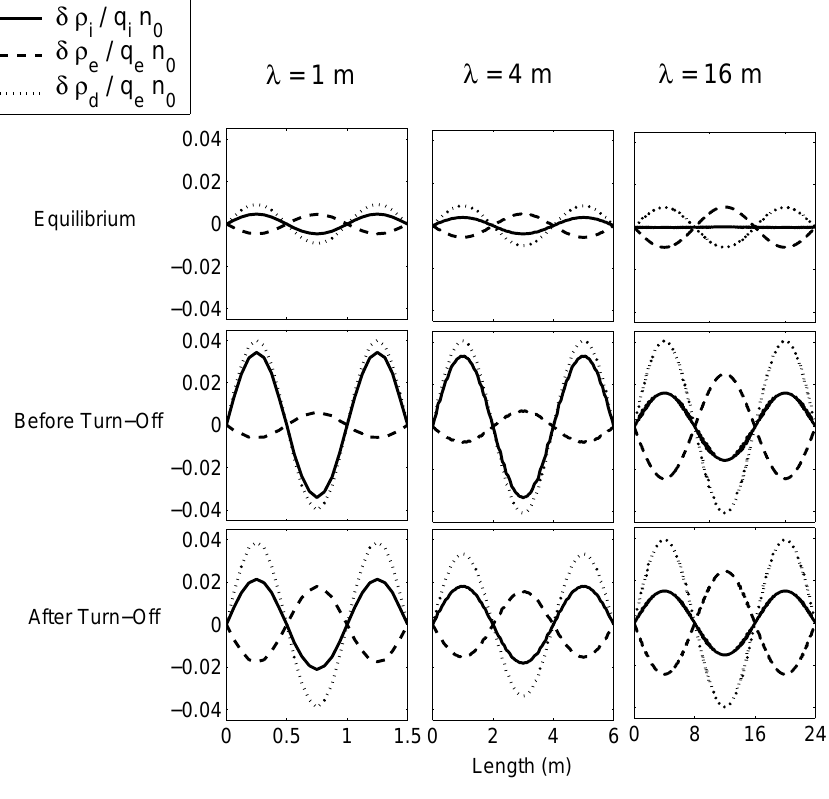
Fig. 2. Spatial presentation of electron ( δρ e /q e n 0 ), ion ( δρ i /q i n 0 ), and dust ( δρ d /q e n 0 ) irregularities before, during, and after radiowave heating with varying irregularity wavelength (1, 4 and 16m) as shown in Fig.